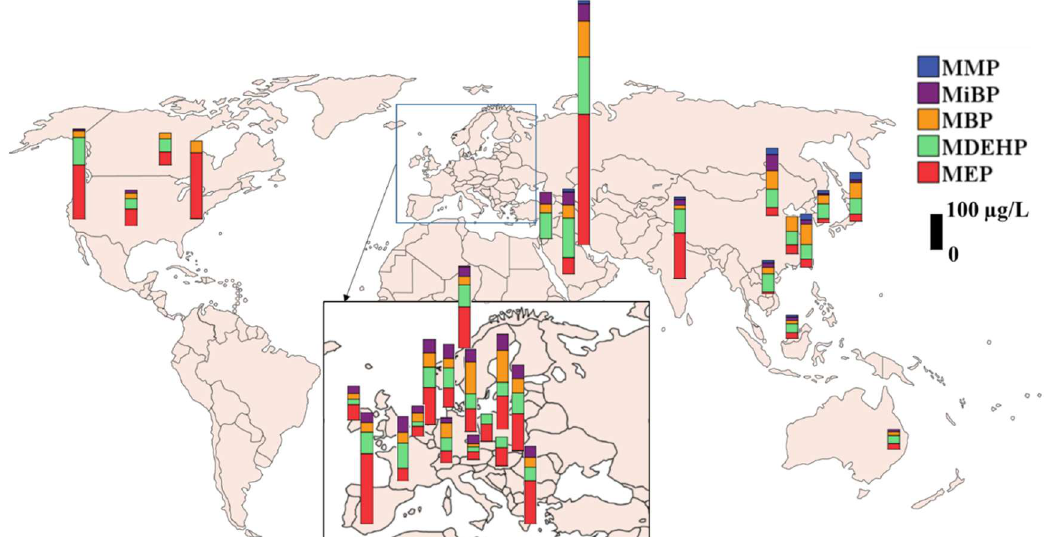
Figure 3. Urinary concentrations of phthalate metabolites reported in adults (general population) from several countries (MDEHP: Sum of DEHP metabolites; biomonitoring data published after 2000; median concentration is presented).